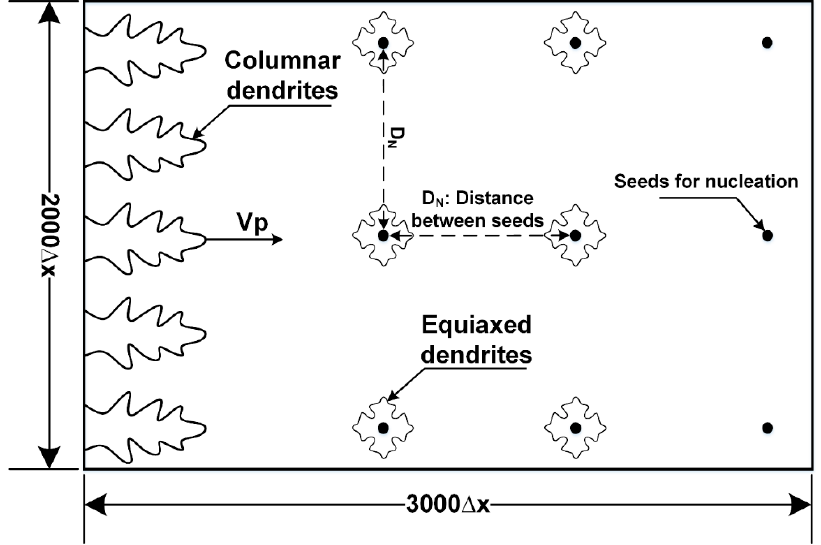
Figure 4. The setting of heterogeneous nuclei in the computational domain.